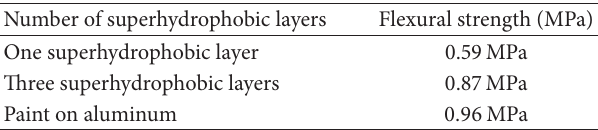
Table 2: Peel force for two different samples SR/TiO 2